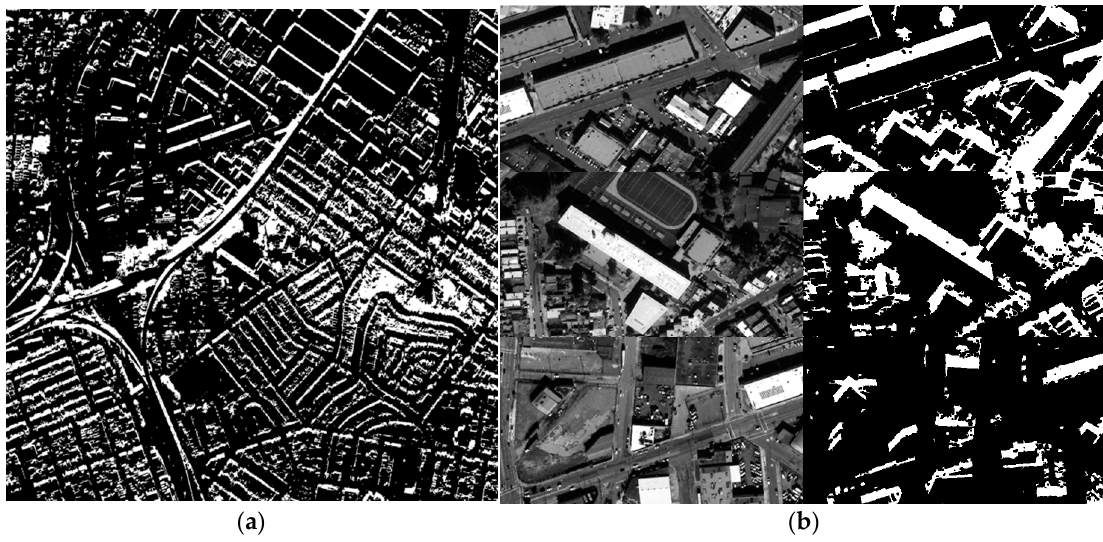
Figure 7. The ISM extracted from the sample dataset’s QB image: ( a ) Result of the overall application (White regions are shadows); ( b ) Enlarging the result of applying algorithm on three regions along the panchromatic image.